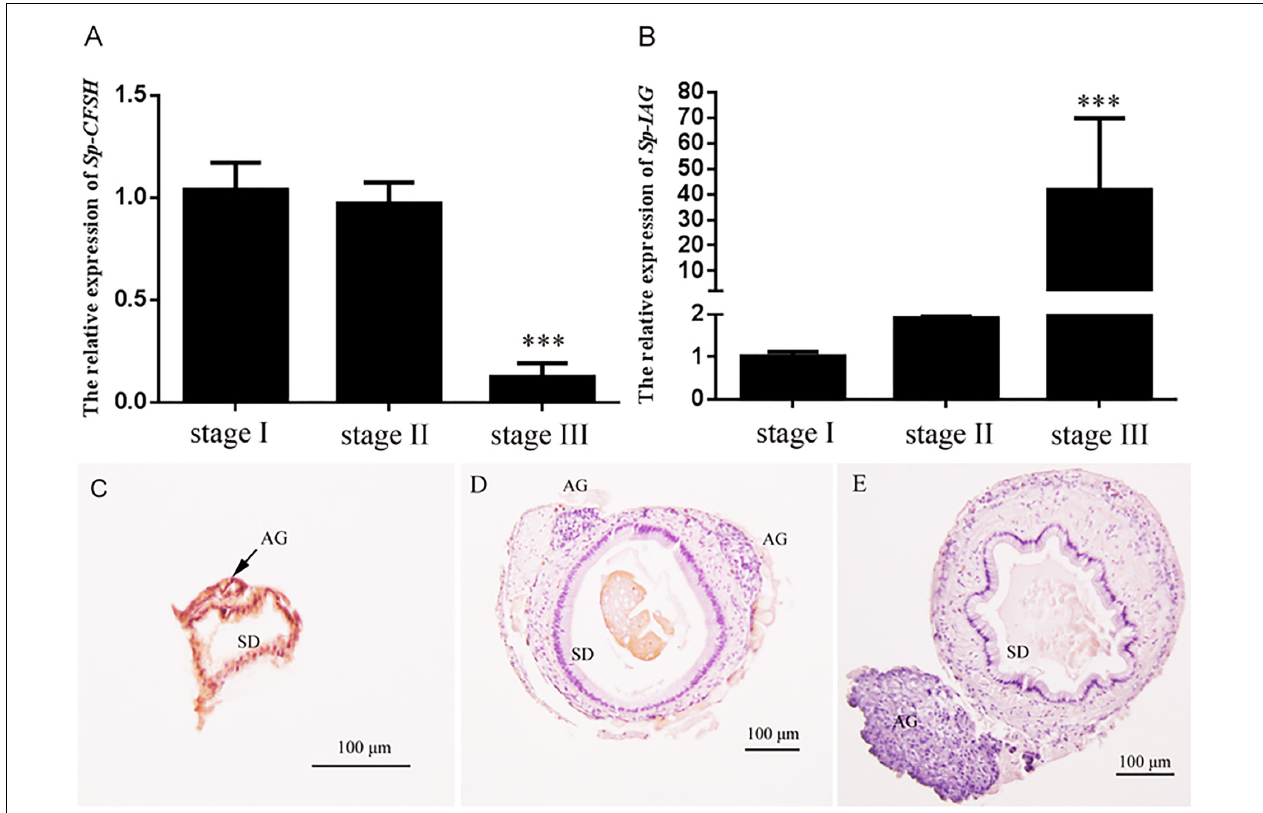
FIGURE 6 | Expression patterns of Sp-CFSH (A) and Sp-IAG (B) , and histological characterization of the androgenic gland (C–E) at three different development stages of male S. paramamosain . Data are shown as means ± SEM of six separate individuals ( n = 6). Asterisks ∗∗∗ ( P < 0.001) on the top of the error bars indicate highly significant differences from stage I. (C) Stage I; (D) stage II; (E) stage III. SD, sperm duct; AG, androgenic gland.